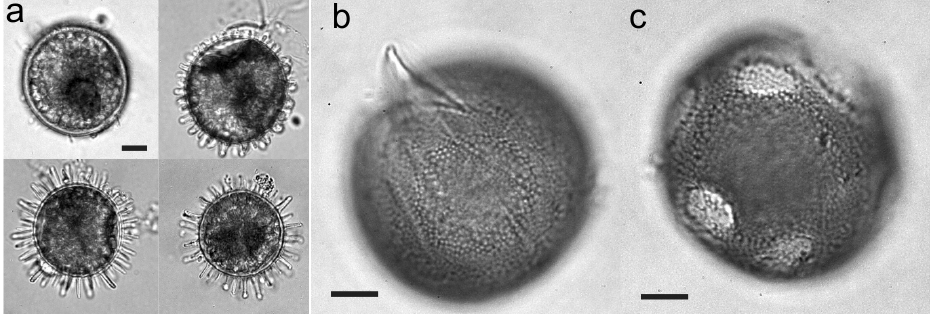
Figure 4. Differences in cyst wall development during the encystment of Lingulodinium polyedrum ( a ) and Gymnodinium catenatum ( b , c ). Scale bar: 10 µm. Adapted from [22] and [24]. a b